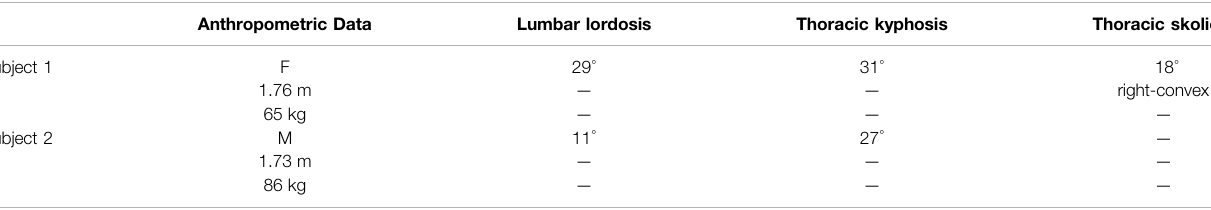
TABLE 1 | Anthropometric data and parameters on the individual spinal alignment of selected subjects. Anthropometric Data Lumbar lordosis Thoracic kyphosis Thoracic skoliosis